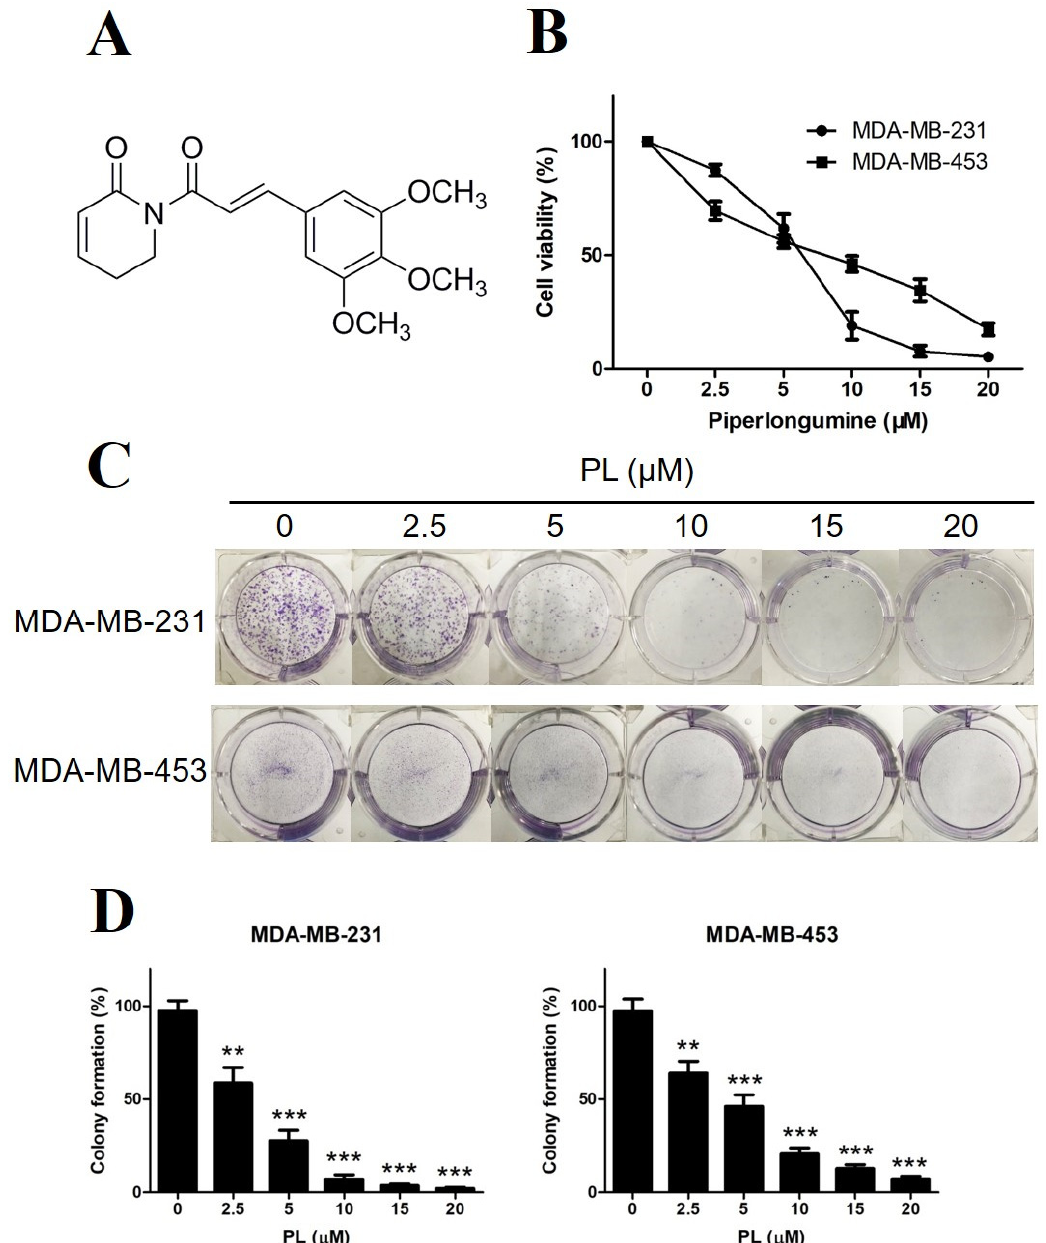
Figure 1. Piperlongumine inhibits proliferation of TNBC cells. ( A ) Molecular structure of piperlongumine. ( B ) MDA-MB-231 and MDA-MB-453 cells were treated with different concentrations